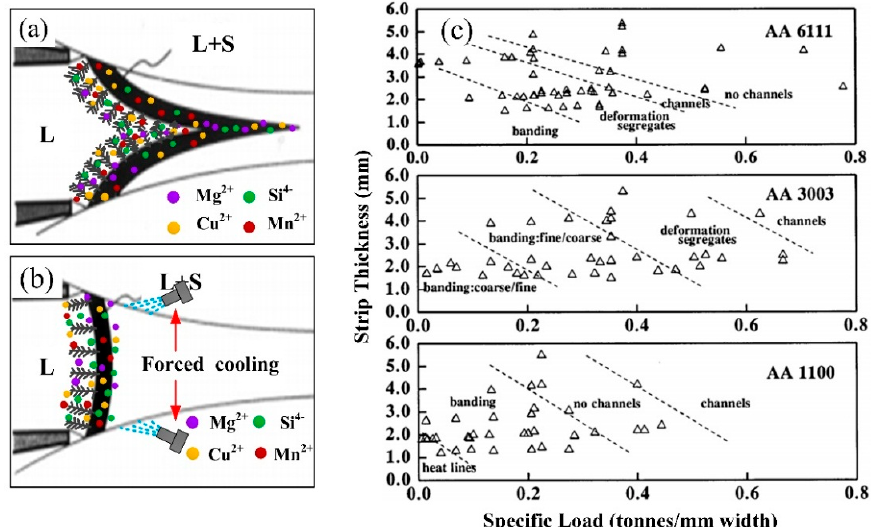
Figure 8. Formation mechanism of segregation defects. ( a ) Sharp crystallization front shape of traditional TRC, ( b ) smooth crystallization front shape of FC-TRC, ( c ) defect limit diagram of different alloys [24].